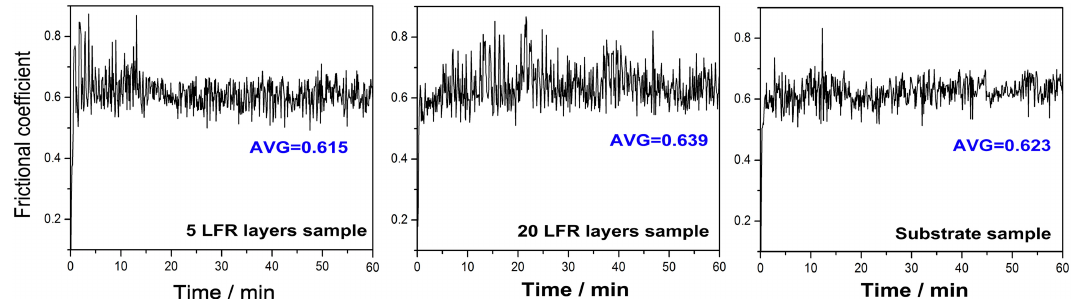
Figure 9. Frictional coefficients of three kinds of sample.